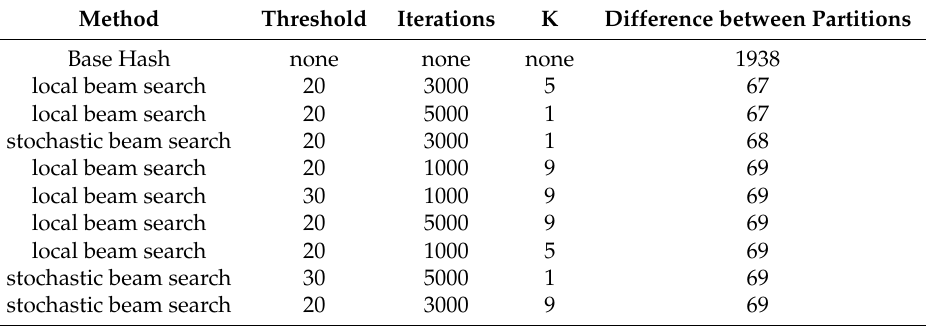
Table 1. The ten best balancing results compared with the base hash